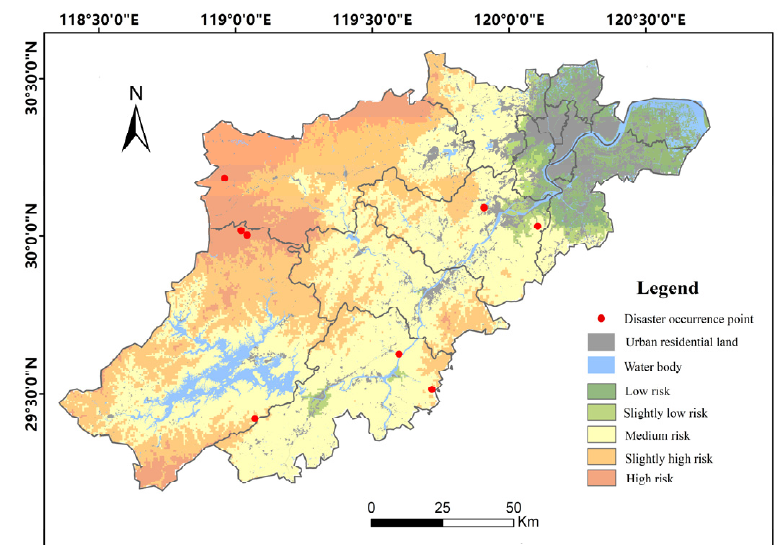
Figure 4. Risk map of freezing injury of tea with weak cold resistance. According to the hazard annual report data in the basic database of hazard prevention and reduction in Hangzhou, the locations of the actual tea frost hazards are all in areas with high-risk levels (Figure 4), which proves that it has high reliability and can be used as a source for model sample selection. In Hangzhou water bodies and other areas outside urban residential land, 1000 sample point data points were evenly selected, and the specific spatial distribution is shown in Figure 5